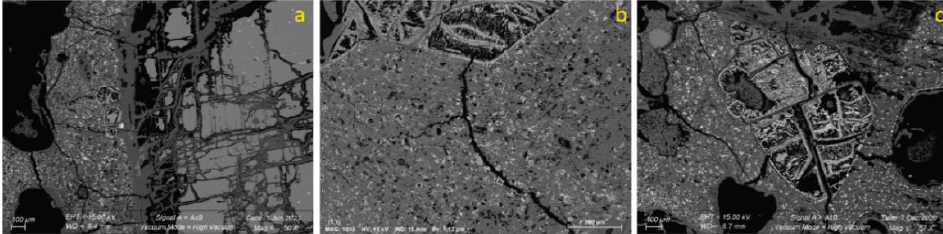
Figure 13. DJI-4-1 SEM pictures in AsB mode displaying ( a ) a centimeter-scale plagioclase partially altered to kaolinite/smectite with an olivine next to it in a smectite and oxide matrix; ( b ) close-up view of the iron-rich smectite matrix near a Mn-oxide; ( c ) fractured Mn-oxide with white Fe enrich- ment .